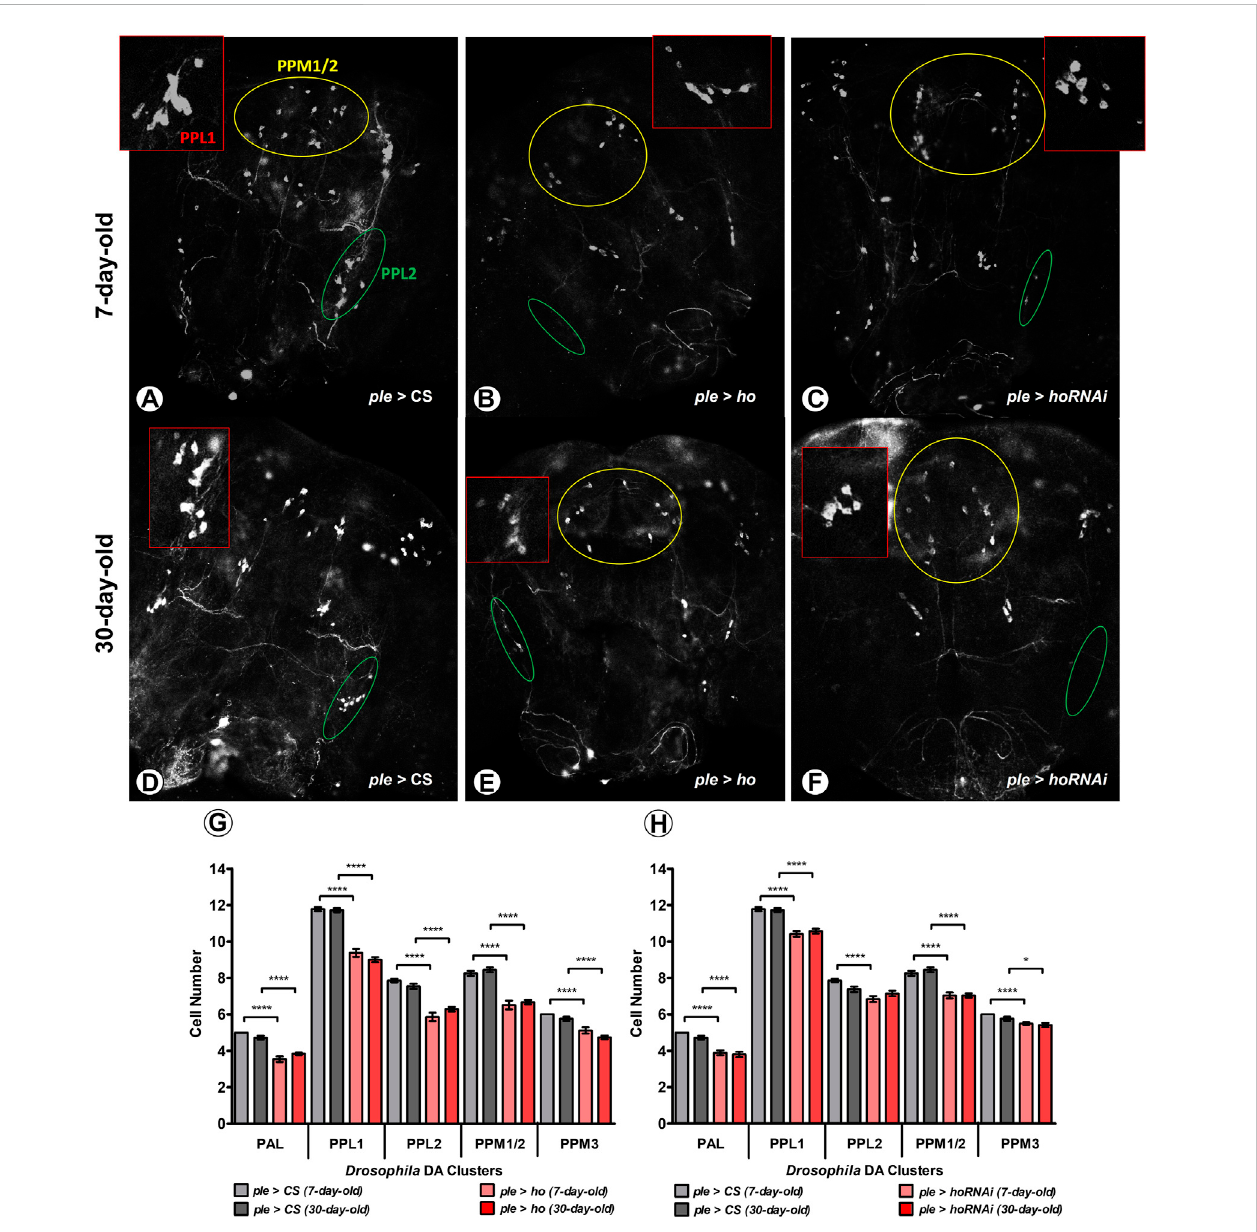
FIGURE 4 Increasing or decreasing the ho expression generates degeneration in DA cell clusters at an age-dependent manner. Dopaminergic (DA) neurons were particularly vulnerable to changes in ho expression levels and cell loss was higher in young fl ies (A – C) compared to older ones (D – F) in fi ve different DA clusters. Statistically signi fi cant differences in DA cell number (G,H) , means± SEM) between genotypes or different age groups are indicated with asterisks (7- day-old vs. 30-day-old in each genotype, analysed by parametric unpaired t- test with Welch ’ s correction between genotypes by age: * p ≤ 0.05, ** p